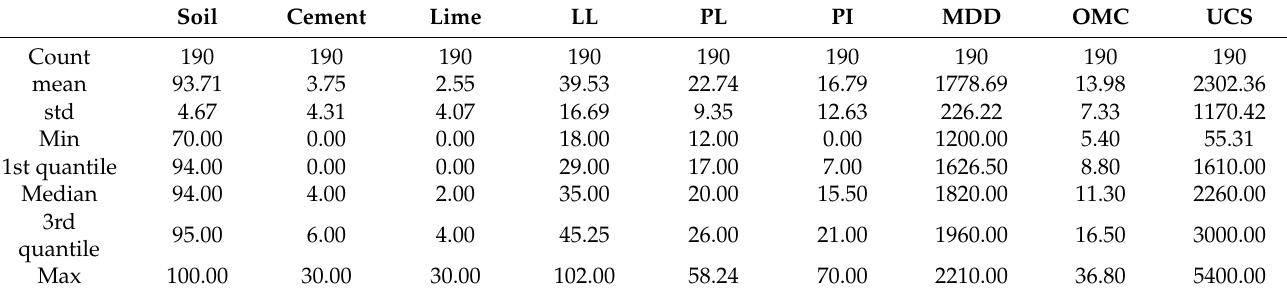
Table 2. Descriptive statistics of the